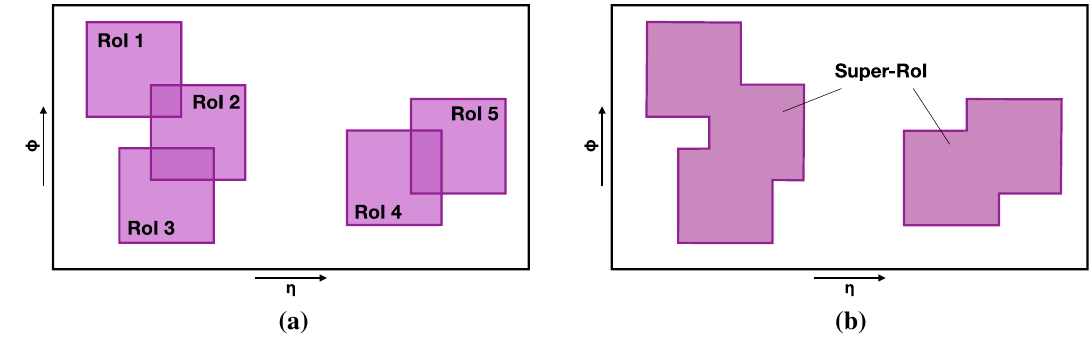
Fig. 2 A representation of the two different approaches to processing RoIs in the detector. In the standard approach ( a ), each RoI is treated separately, resulting in overlapping regions of the detector being pro- cessed multiple times. In the super-RoI approach ( b ) the different RoIs